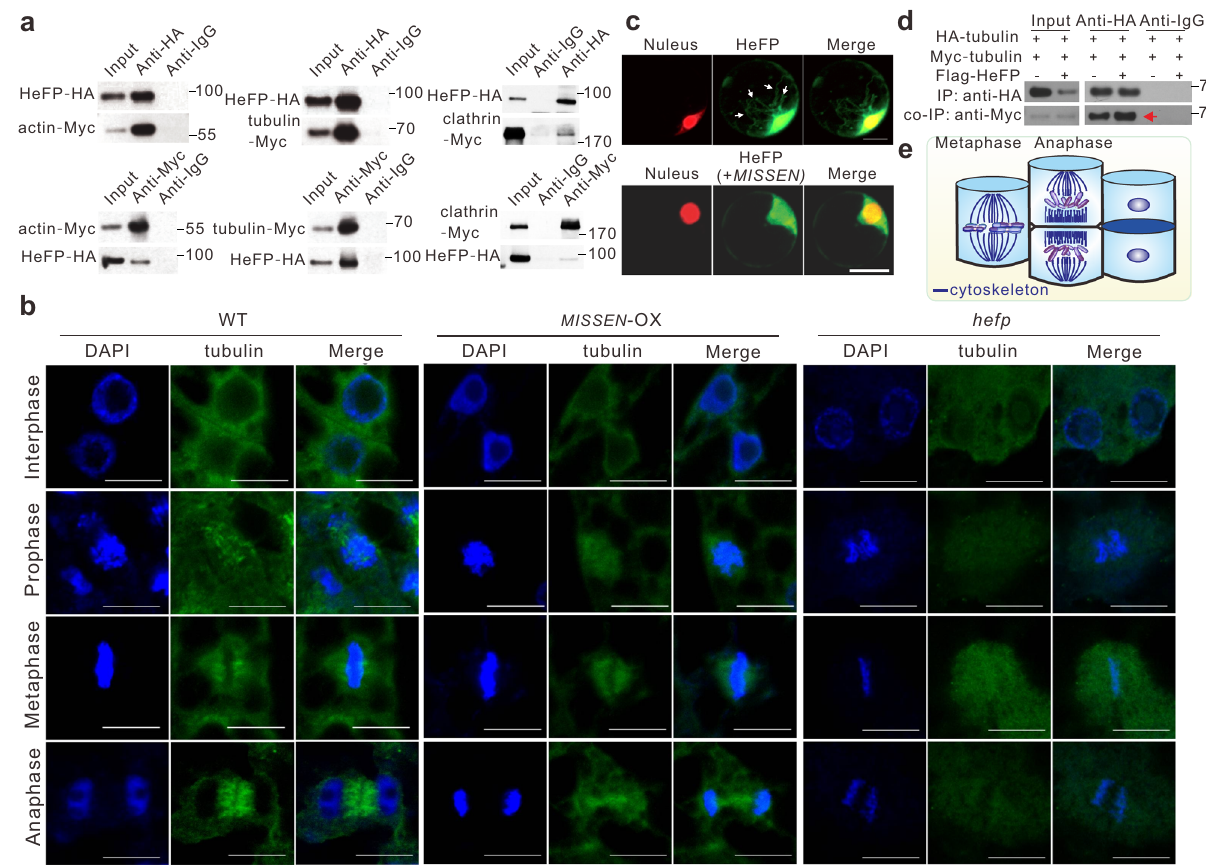
Fig. 5 HeFP and MISSEN affect microtubule polymerization. a In vitro binding assays between HeFP and actin, tubulin, and clathrin. The experiment was repeated three times with similar results and one representative result was shown. b Microtubule arrays were visualized by immunostaining with anti- alpha-tubulin during mitosis in WT, MISSEN -OX, and hefp endosperm cells at 3 DAP. Microtubules are colored green, and nuclei or chromosomes are colored blue. Scale bars, 10 µ m. The experiment was repeated three times with similar results and one representative result was shown. c Subcellular localization of HeFP with or without MISSEN . Arrows indicate the fi lamentous distribution of HeFP. Scale bars, 10 µ m. The experiment was repeated three times with similar results and one representative result was shown. d Co-express HA-tagged and Myc-tagged tubulin in protoplast and evaluate the level of microtubule polymerization by co-IP assay to detect the degree of interaction between HA-tagged and Myc-tagged tubulin. The result showed that HA- tagged tubulin immunoprecipitated more Myc-tagged tubulin when HeFP was overexpressed (indicate by an arrow), suggesting HeFP facilitates microtubule polymerization. The experiment was repeated three times with similar results and one representative result was shown. e Schematic diagram of the cytoskeleton during endosperm